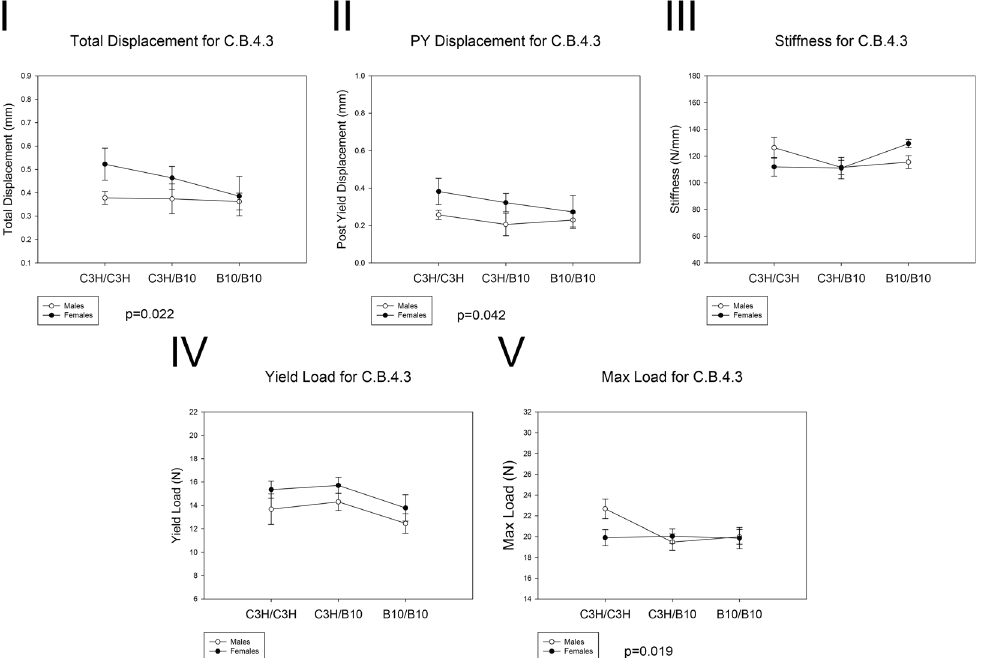
Fig 2. Whole Bone Mechanical Performance of C.B.4.3 mice. Open circle: males. Black circle: females. The effects of genotype on (I) total displacement, B10/B10 < C3H/C3H (p = 0.022). (II) PYD, p = 0.042 for sex differences across all genotypes. (V) Max load, p = 0.019 for differences in males (B10/B10 and C3H/B10 < C3H/C3H). No significant differences in (III) stiffness and (IV) yield load between